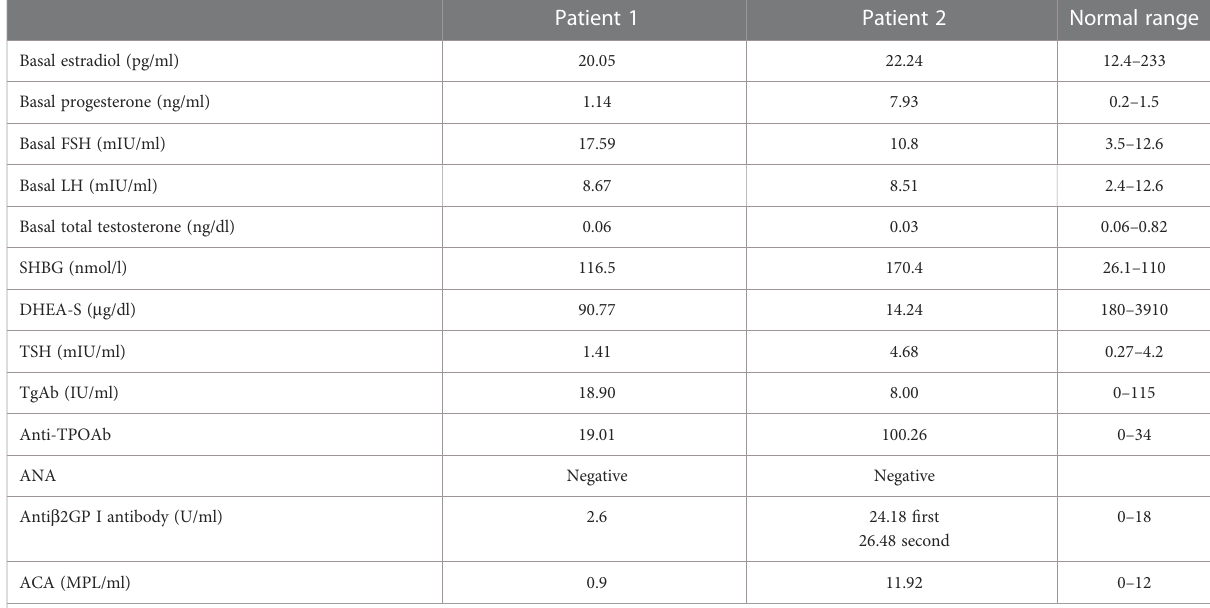
TABLE 1 Synopsis of the basal hormonal